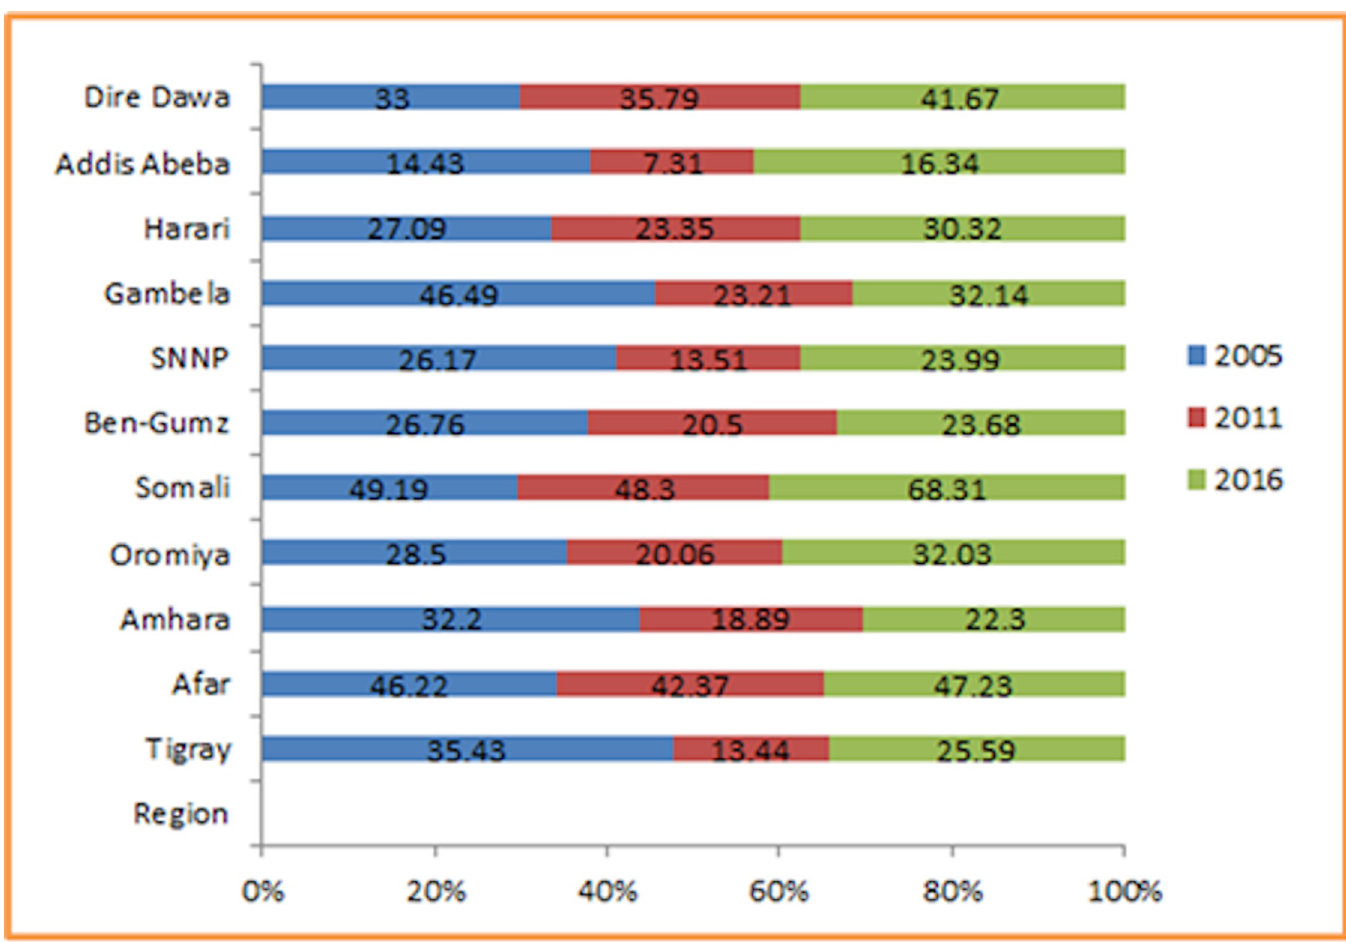
Fig 2. Trends of anemia among lactating mothers in Ethiopia overtime across regions 2005, 2011, and 2016.